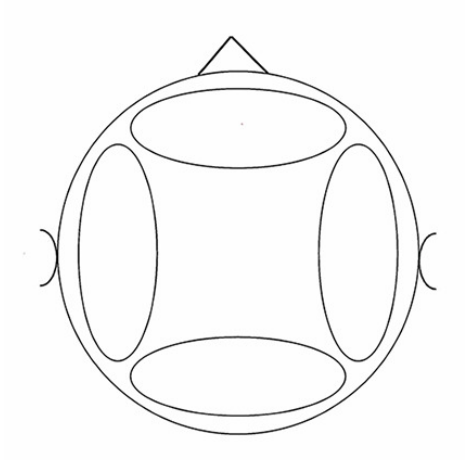
Figure 11. An illustration of the auditory map for subjects (horizontal-plane). During the test, the subjects were asked to mark the areas according to the sound source location they heard through